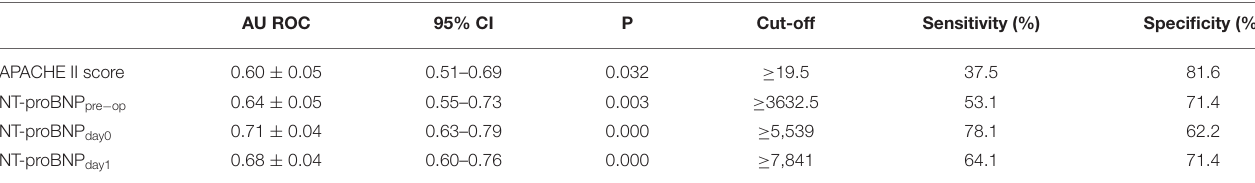
TABLE 4 | Performance of variables in predicting 28-day